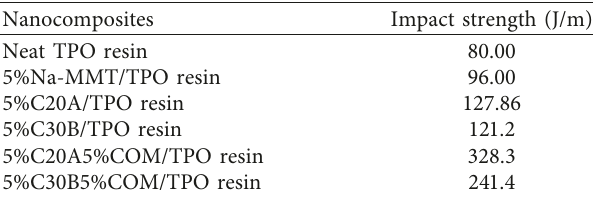
Figure 6: Geometry of DCB specimens. Table 3: Effect of clay content on impact strength for